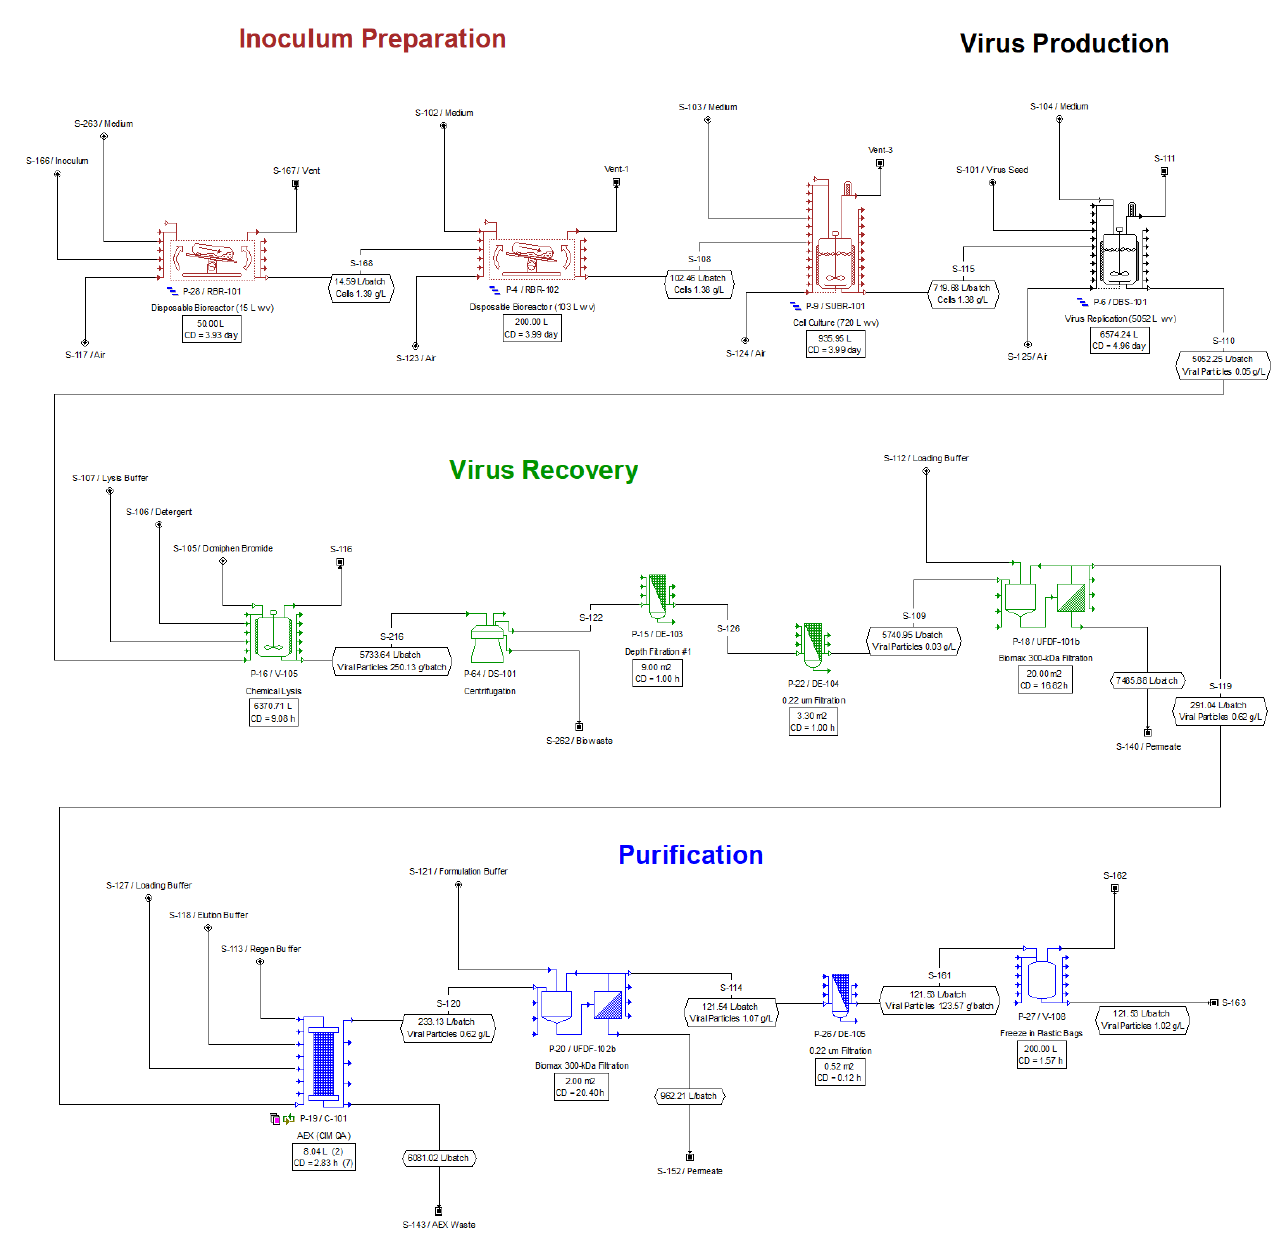
Figure 1. Simplified process flow diagram for the production of a COVID-19 adenoviral vector vaccine.